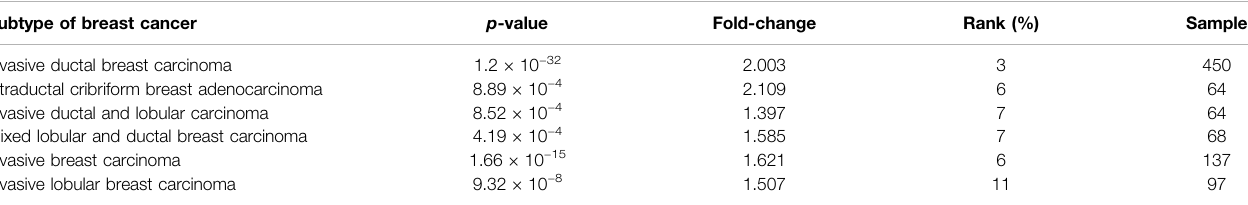
TABLE 1 | Signi fi cant changes in PGK1expression at the transcription level between different types of breast cancer and normal tissues (oncomine database). Subtype of breast cancer p -value Fold-change Rank (%) Sample Invasive ductal breast